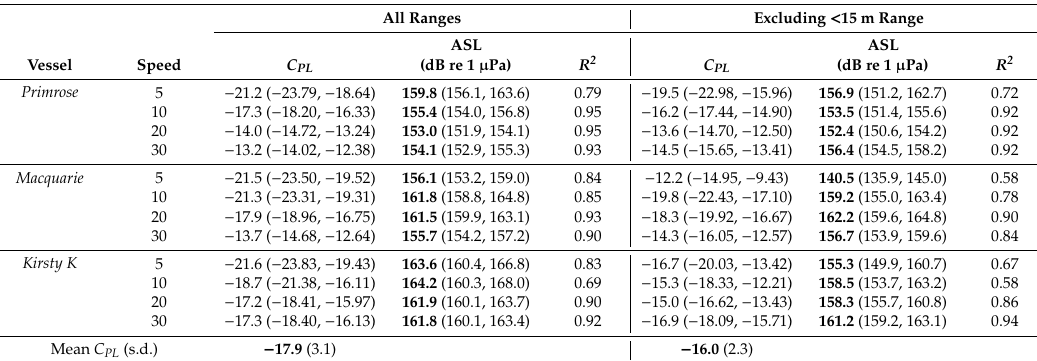
Figure 4. Received sound pressure levels from directly beneath the vessel (9 m range) to the 100 m range for ( a ) Primrose , ( b ) Macquarie and ( c ) Kirsty K , at speeds of 5, 10, 20 and 30 km h − 1 (green circles, beige diamonds, red circles and blue squares, respectively). Table 3. Propagation loss coefficients ( C PL ) and affected source levels for individual vessels and speeds determine from Equation (1) for all ranges and for only ranges > 15 m. Mean log 10 ( range ) loss values (and standard deviation) found across all regression models with all data and for ranges > 15 m are also included.